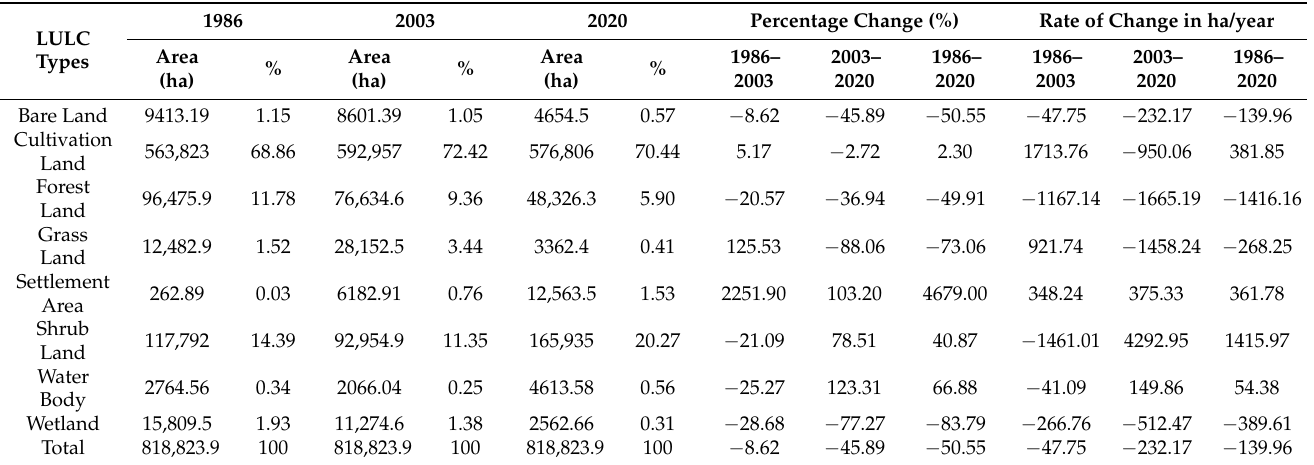
Table 5. LULC change the percentage and rate of change in the Muger sub-basin between 1986, 2003, and 2020 adapted from